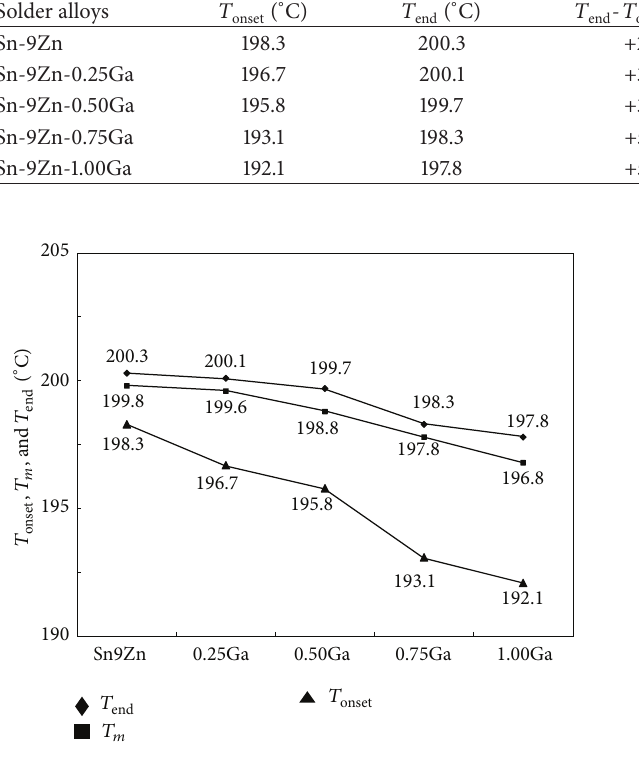
), melting temperature onset ) of various solder alloys. end